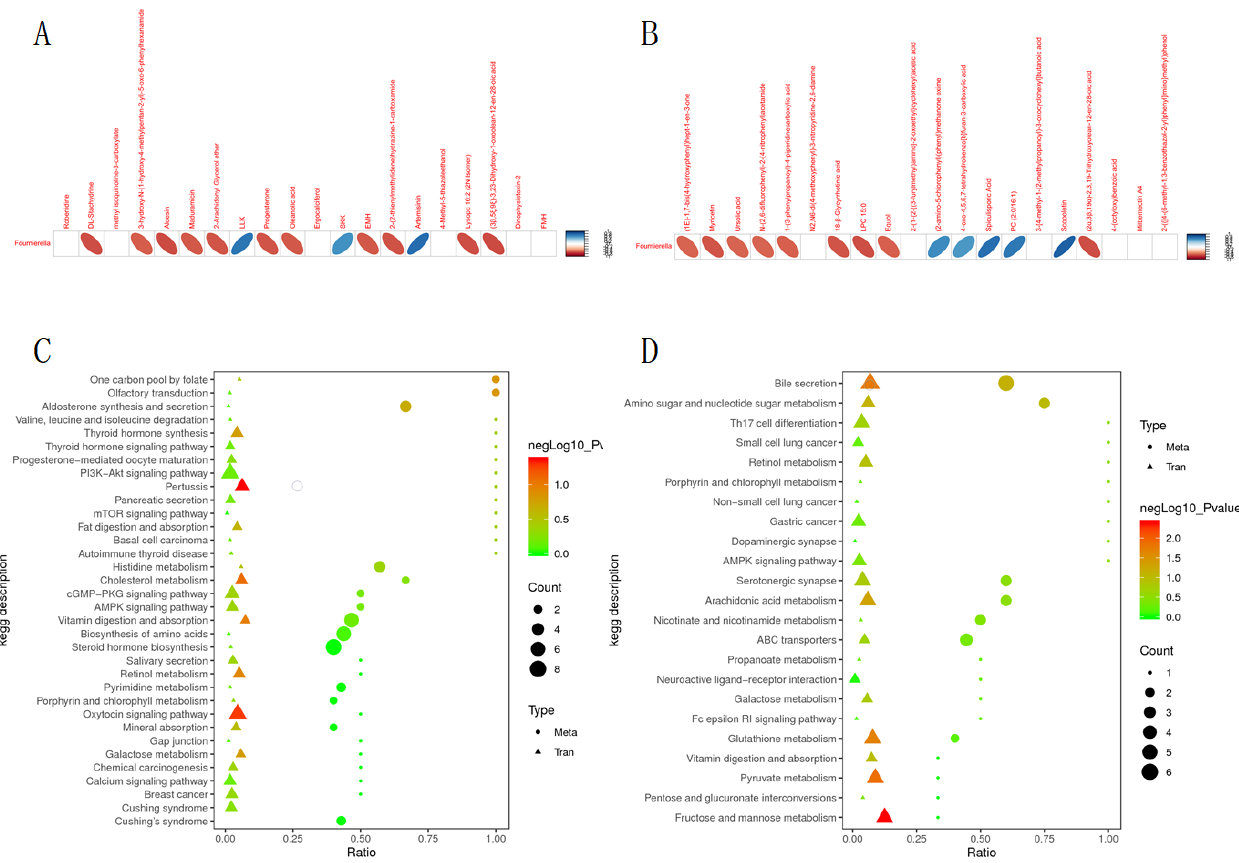
Figure 6. Correlation of DM with cecum bacteria and DEGs. ( A , B ) Correlation analysis results of metabolites top20 and 16S differential bacteria top10. ( C , D ) KEGG enrichment analysis of metabolism and transcription. Note: ( A , C ) are positive ion modes; ( B , D ) are negative ion modes.